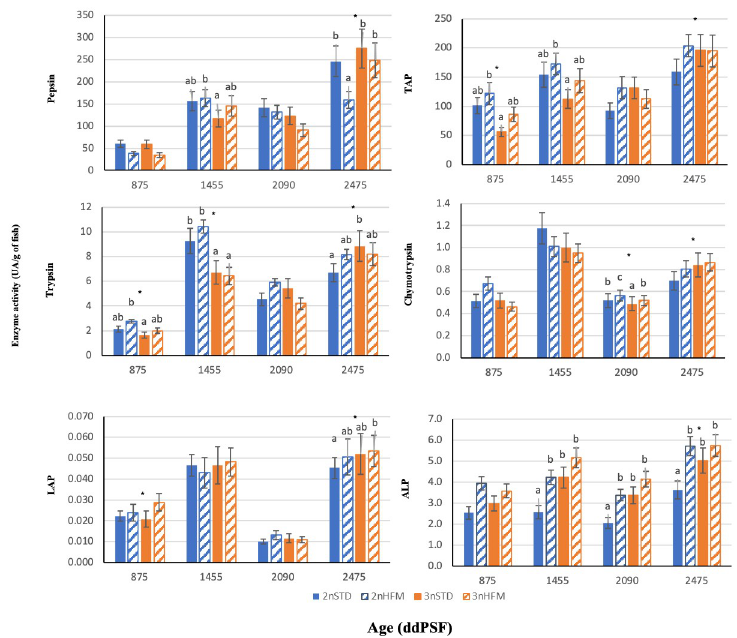
Fig 9. Digestive enzymes activities of diploid (2n) and triploid (3n) Atlantic salmon, Salmo salar , fed fish meal (STD) and hydrolysed fish protein (HFM) diets. Pepsin, total alkaline proteases (TAP), trypsin, leucine aminopeptidase (LAP), chymotrypsin and alkaline phosphatase (ALP) activities are expressed as UA/g of fish measured at 875, 1455, 2090 and 2745 ddPSF (see Table 1). Different lower case letters denote significant differences (P < 0.05) between groups. ( � ) Indicates significant differences between 2n and 3n in each sampling (P < 0.05). Data are presented as means ± SE (n = 15).